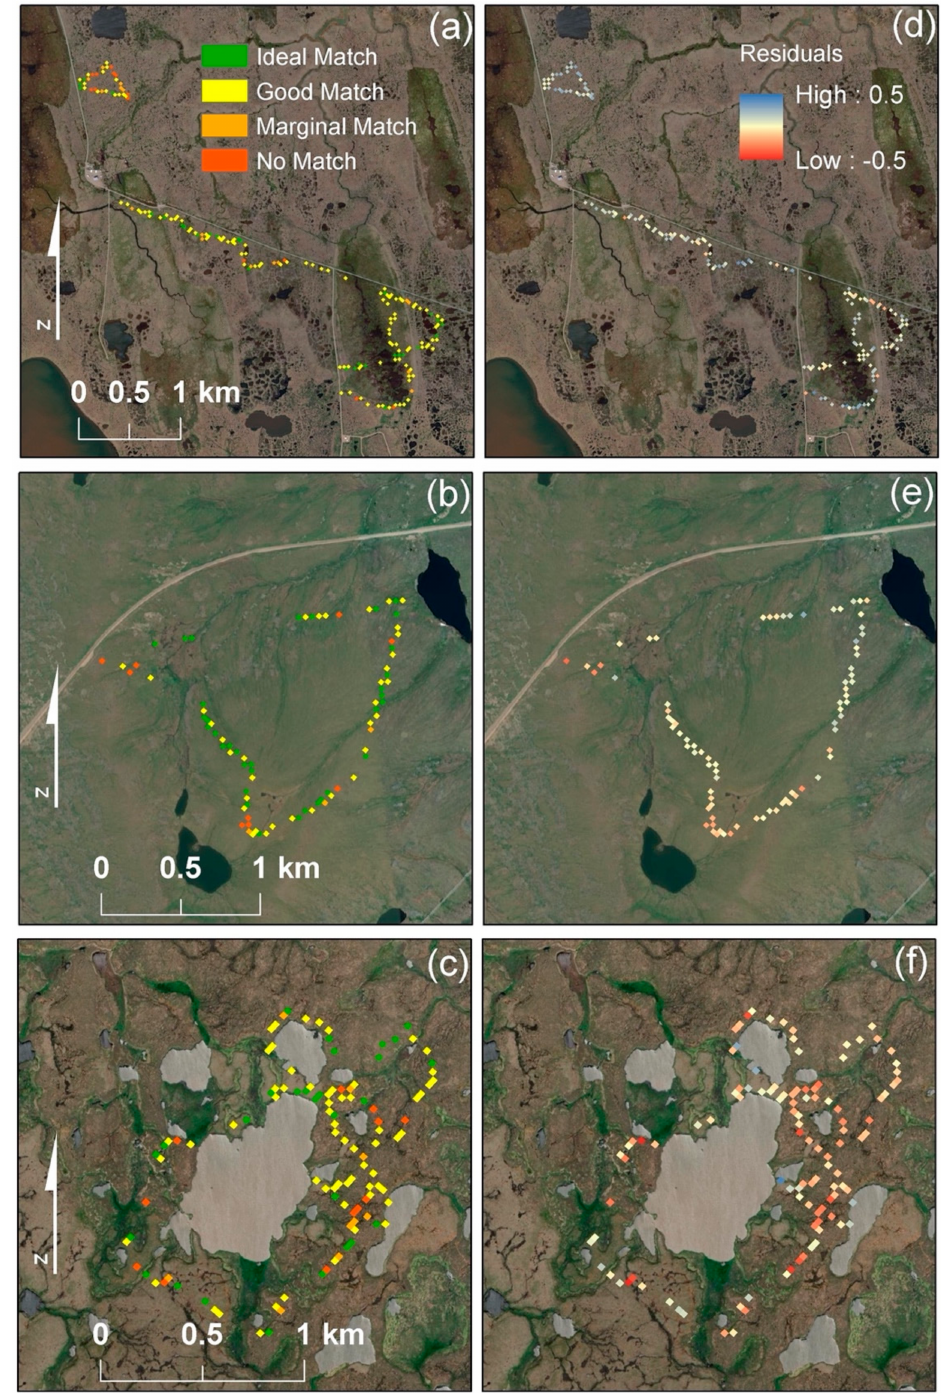
Figure 9. χ 2 classifications for ( a ) BRW, ( b ) TOO, and ( c ) YKD with corresponding residuals ( d – f